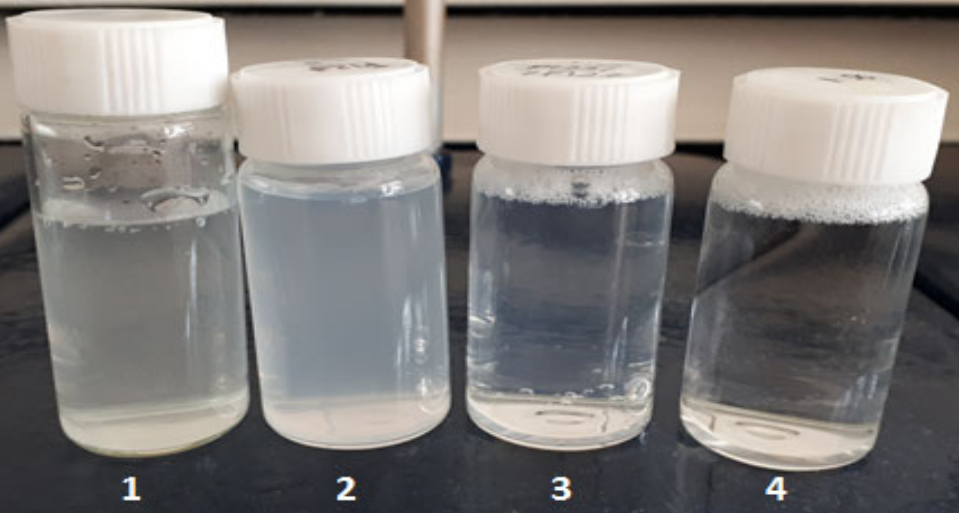
Figure 1. Comparison of the naringenin suspension (0.125 mg/mL) ( 1 ), and naringenin ‐ loaded micelles solutions in water with various drug to polymer ratios: Pluronic P123 micelles 1:5 C = 0.750 mg/mL ( 2 ), Pluronic P123 and F127 mixed micelles 1:5 C = 0.750 mg/mL ( 3 ), Pluronic P123 and F127 mixed micelles 1:50 C = 6.375 mg/mL ( 4 ).